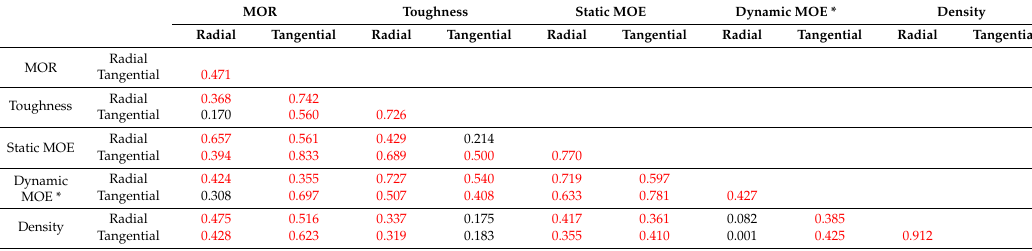
Table A5. Values of Correlation Coe ffi cients Between Given Quantities for Larch Wood.